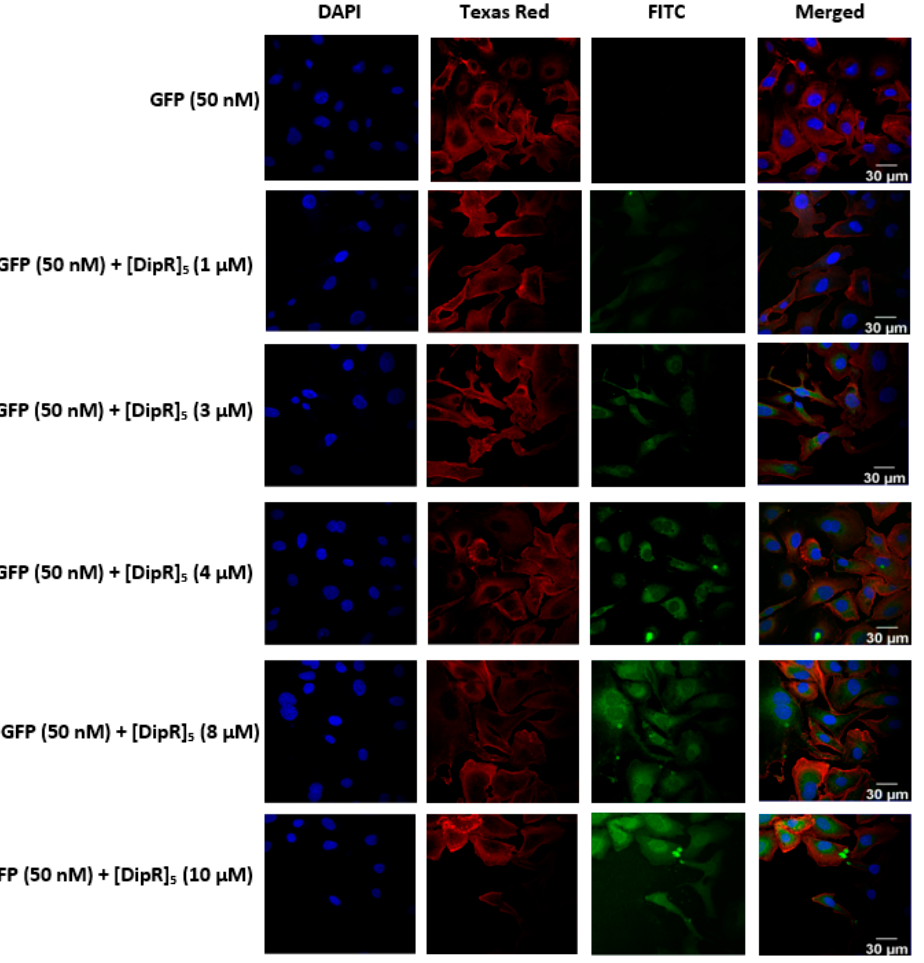
Figure 9. Confocal microscopy images of SK-OV-3 cells incubated with the GFP-[DipR] 5 mixture at a peptide concentration range (1–10 µM) and GFP at (50 nM) for 3 h. The blue, red, and green channels visualize DAPI (used to stain the nucleus), Texas Red (used to stain the cell membrane), and GFP, respectively.